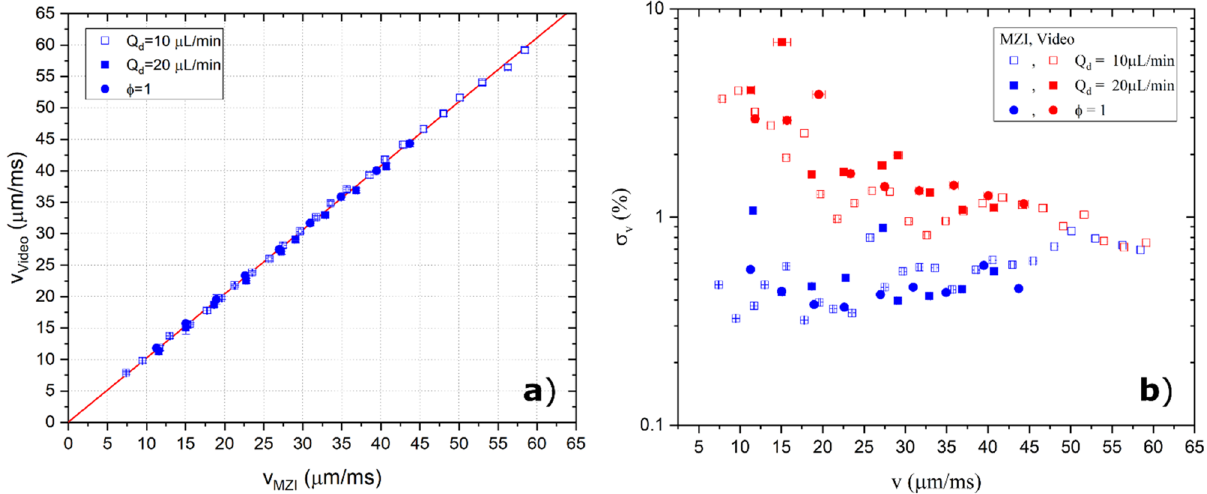
Figure 7. Comparison between the two data acquisition systems (the MZI and the Video) for the emulsion detection. Figure 5a reports the mean of the velocity distribution of each emulsion comparing the one obtained with the Video (in y) and the one obtained with the MZI (in x). The data are labelled distinguishing the three different data sets: Q d constants at 10 and 20 µL/min, Φ = Q d /Q c = 1. The linear interpolation (red line) shows an intercept of 0.1 ± 0.2 µm/ms and a slope of 1.018 ± 0.005. Figure 5b reports the variation of the standard deviations of the velocity distribution of each emulsion over the range of the velocity tested. The data are reported in % with respect to average of the relative distribution and in the log scale. Blue points refer to the MZI distributions and red points to the Video ones, whereas the different markers label the different